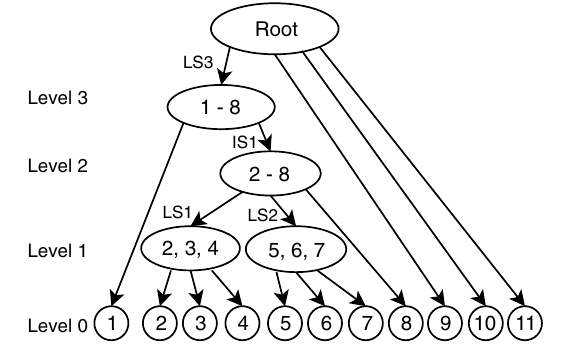
Fig. 5 The modular decomposition tree T of graph ̃